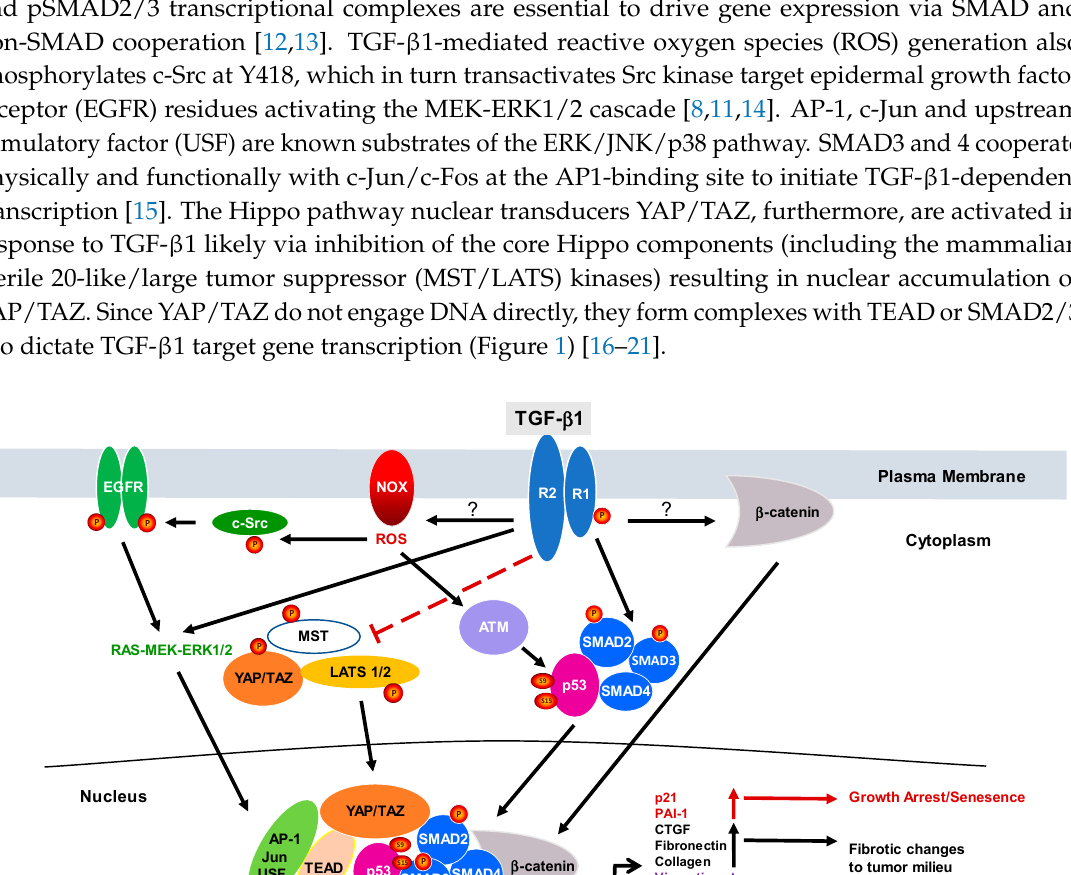
SMAD4SMAD2 p53 p53 RE SBE Figure 1. SMAD and non-SMAD Signaling Cooperation Downstream of TGF- β 1 in Orchestrating Distinct Biological Responses. TGF- β 1 ligand-receptor engagement initiates signaling via both canonical SMAD2/3 and non-canonical (e.g., NOX, p53, YAP/TAZ, EGFR, c-Src, MAPK) pathways impacting transcriptional activation or repression of number of target genes as indicated. Resulting biological outputs may include growth inhibition, oncogenic fibrotic reprogramming, epithelial plasticity and cell growth depending on the contextual role of TGF- β 1 in carcinogenesis.